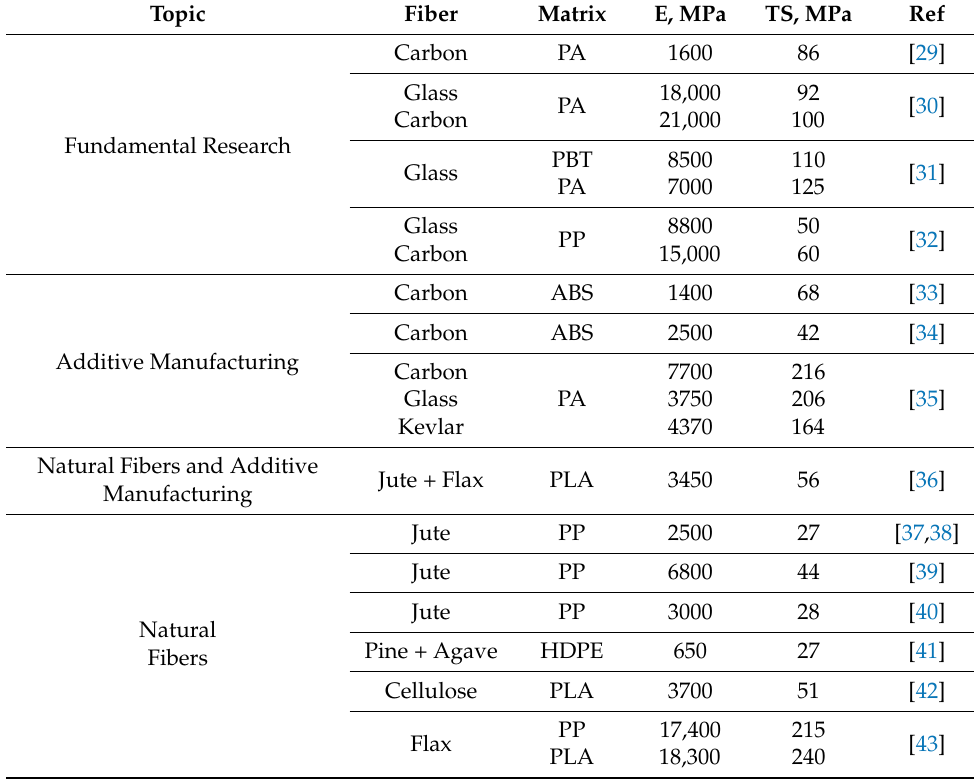
Table 1. Summary of reference literature on FRPs, topics of interest, and tensile properties.